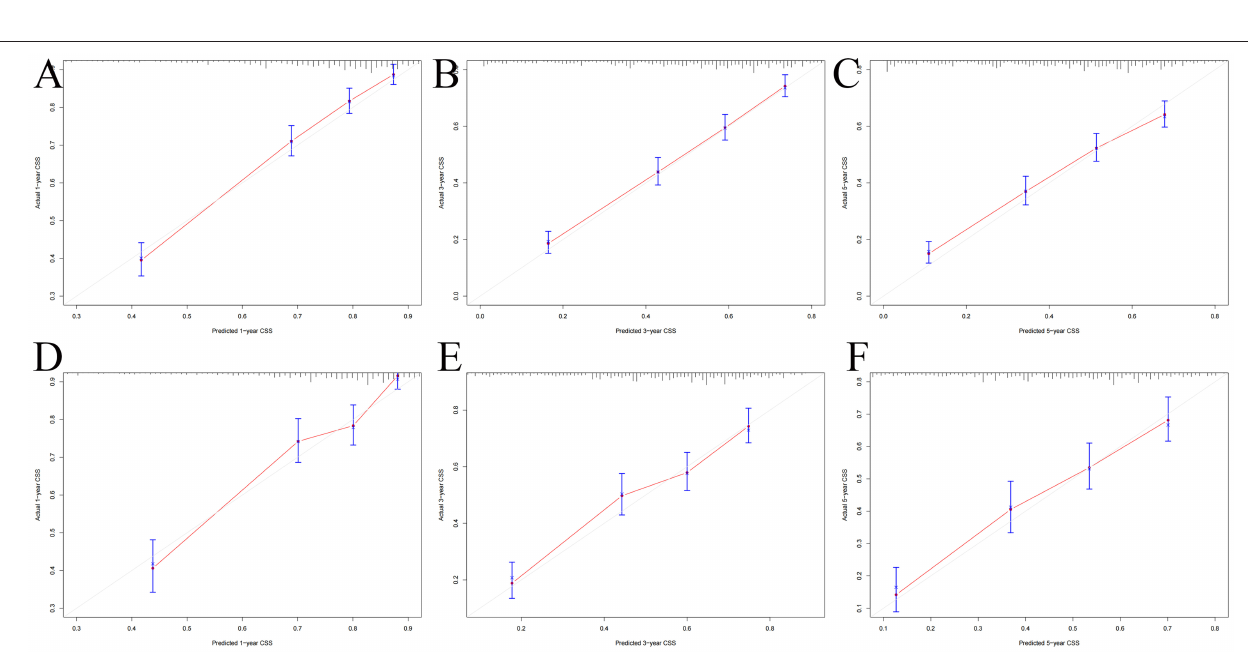
Frontiers in Public Health |